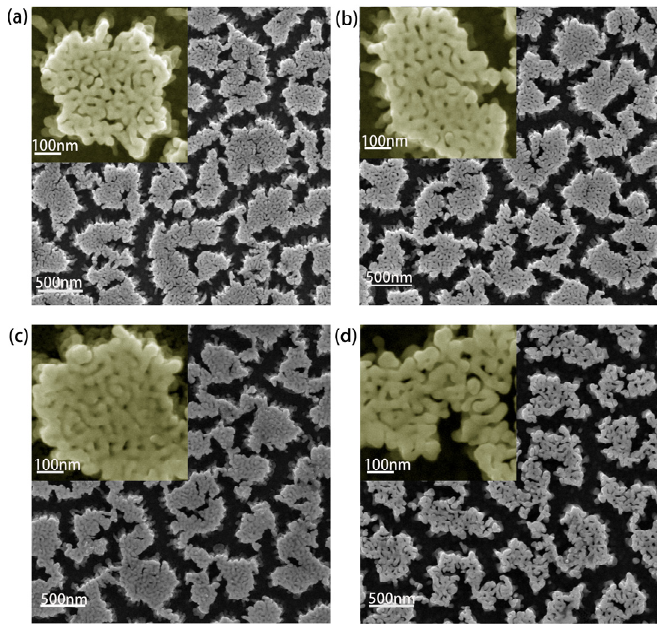
Figure 1. SEM micrographs of NPG with different Ligament sizes. The Ligament diameters are 27 nm ( a ), 32nm ( b ), 38nm ( c ), and 45nm ( d ). Table 1. Component analysis through EDX experiment.